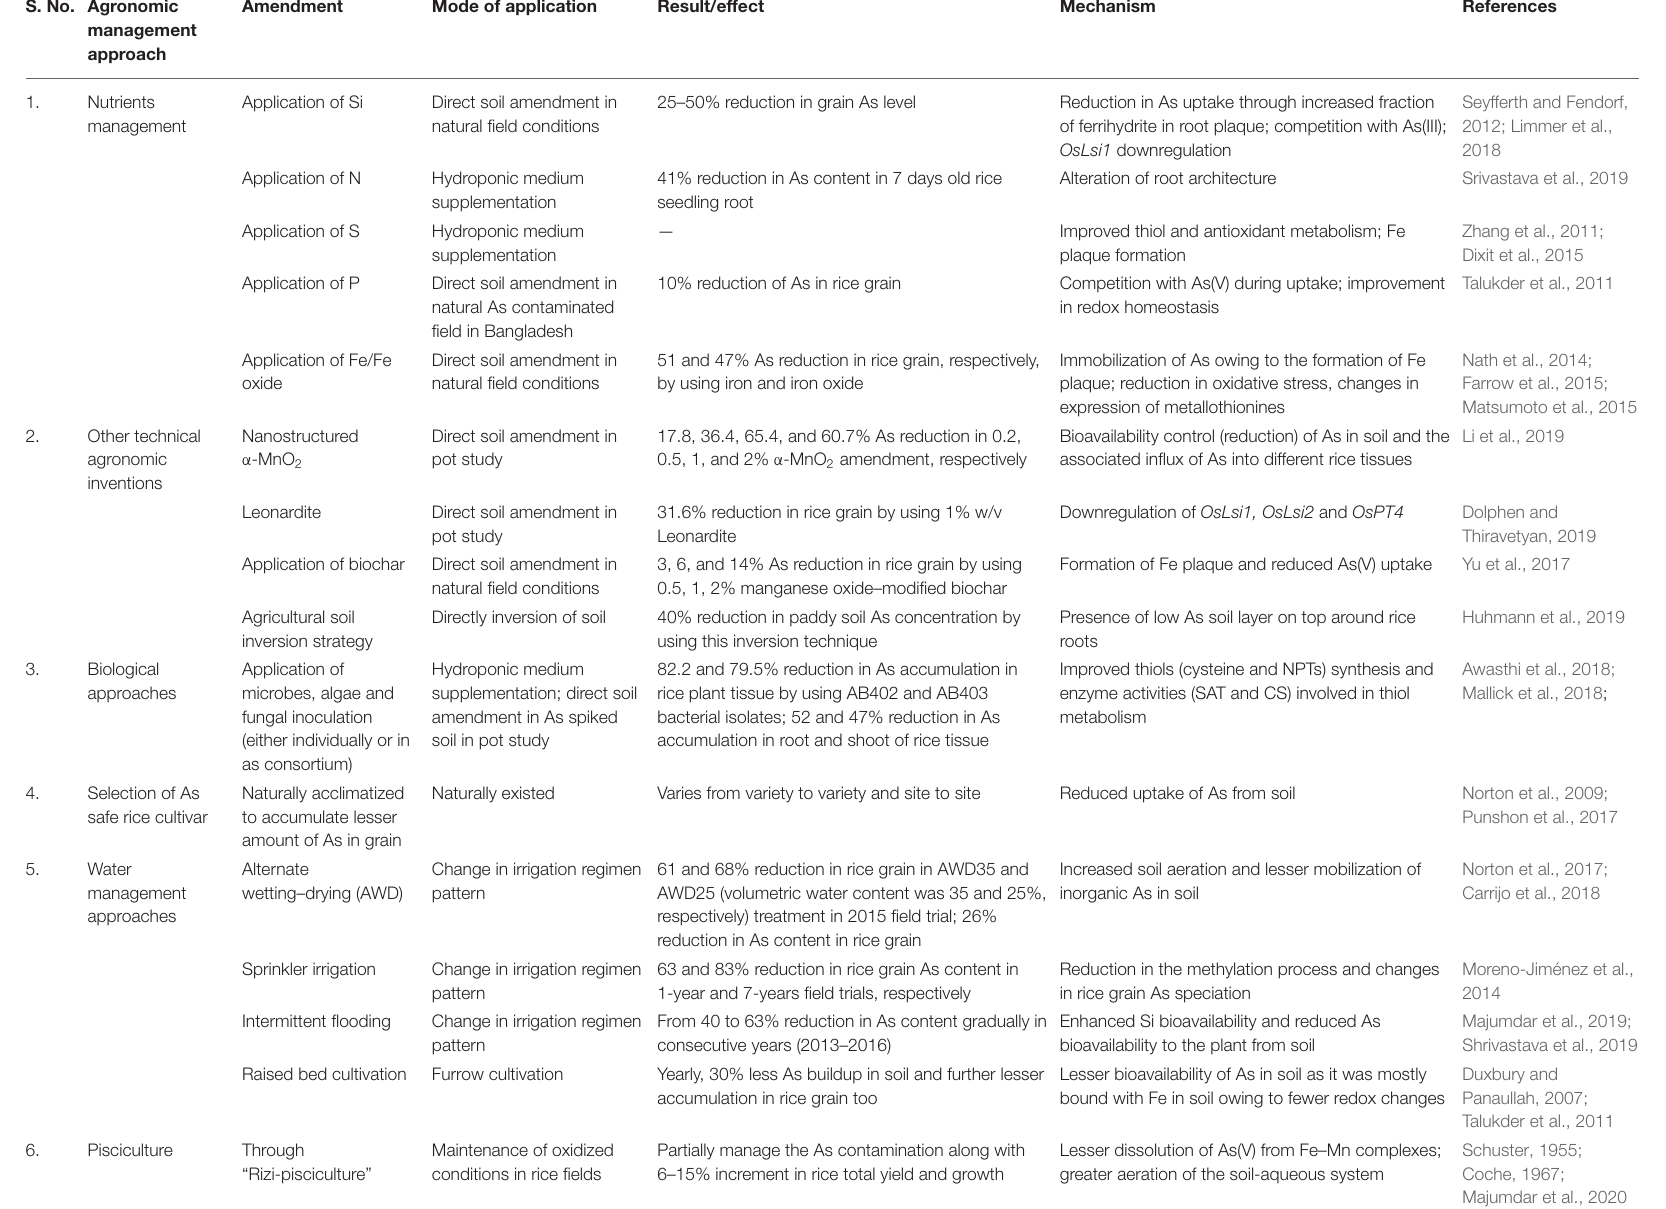
TABLE 1 | Different agronomic management approaches studied through which As accumulation in rice grains can be